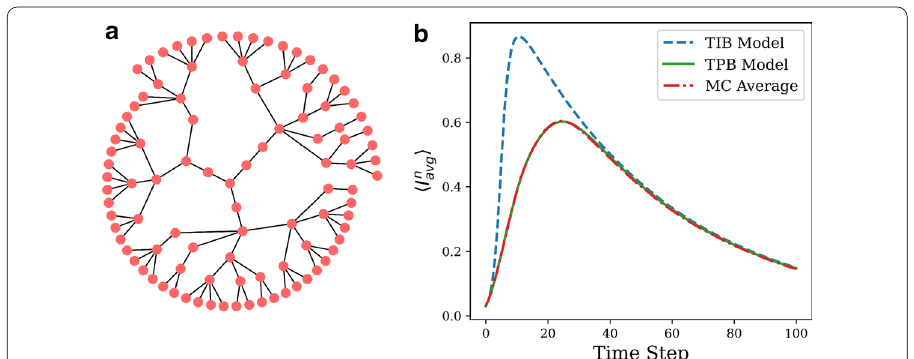
Fig. 2 a A random tree network made up of 100 vertices. b Time series of the TIB (blue dashed) and TPB (green solid) SIR model as well as 10 5 Monte-Carlo (MC) simulations (red dash-dotted) for the tree network shown in a . Parameters: β = 0.4 , µ = 0.02 , and � I 0 0 � = � I 0 1 � =